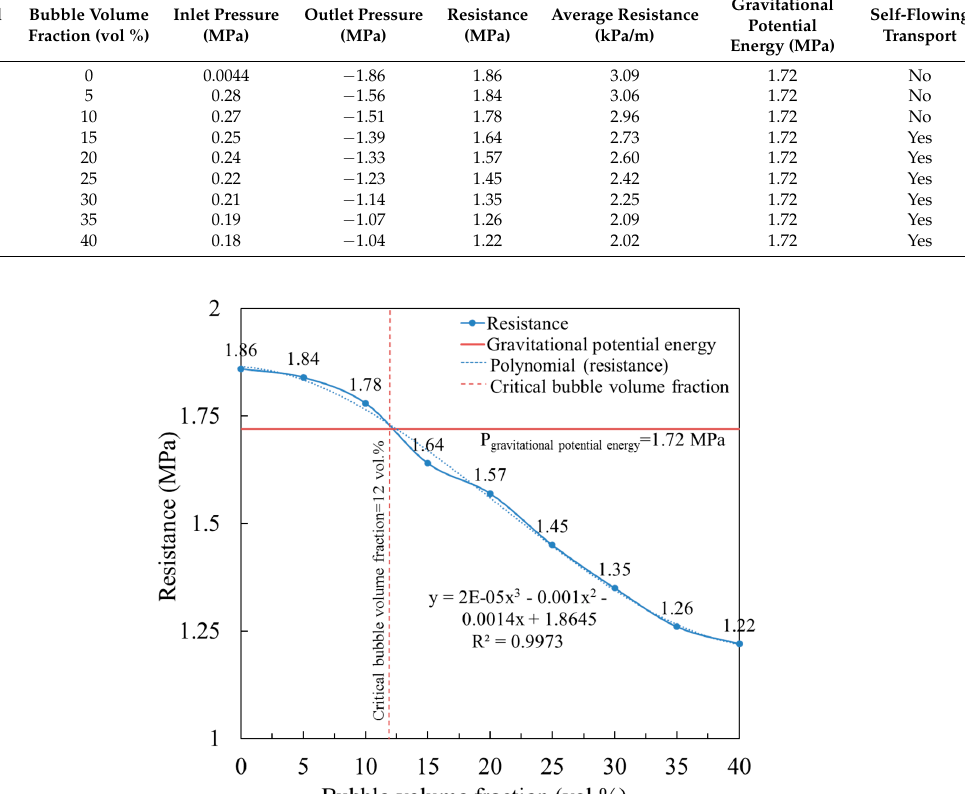
Figure 10. Relationship between total resistance and bubble volume fraction.